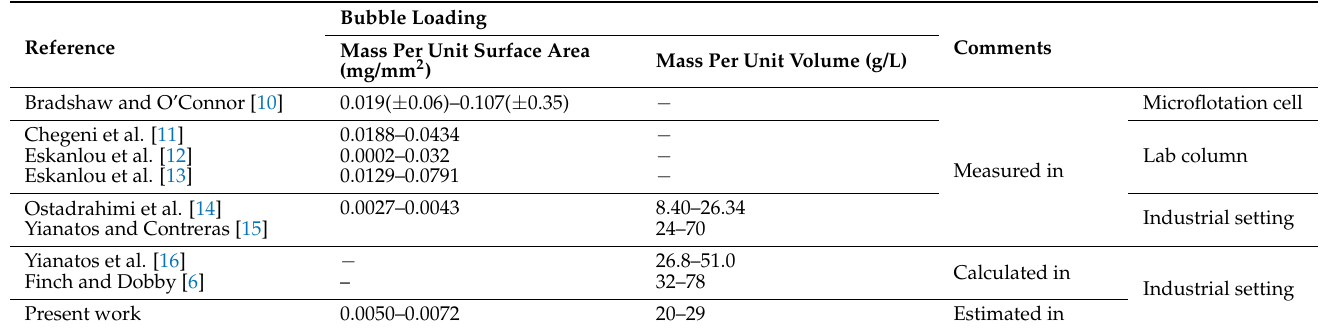
Table 2. Bubble loadings from literature compared with estimate for present